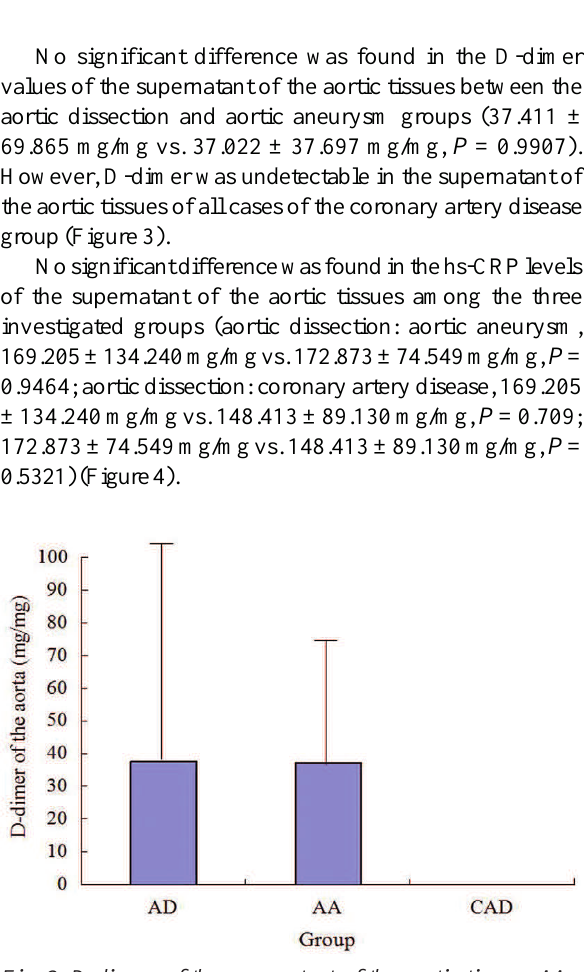
diseaseFig. 2. Plasma hypersensitive C-reactive protein levels. AA - aortic aneurysm; AD - aortic dissection; CAD - coronary artery